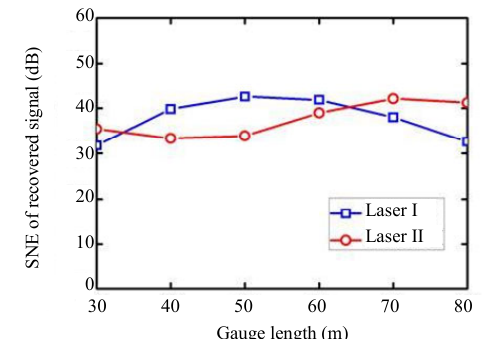
Fig. 5 SNR variation arising from gauge length with a range of 30 m  80